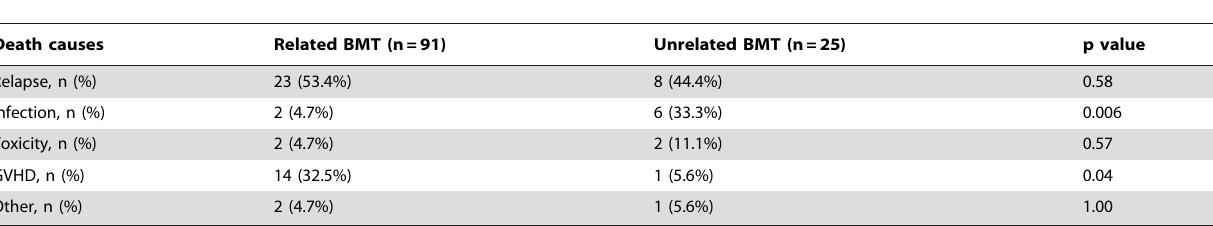
Table 3. Comparison of death causes between related and unrelated